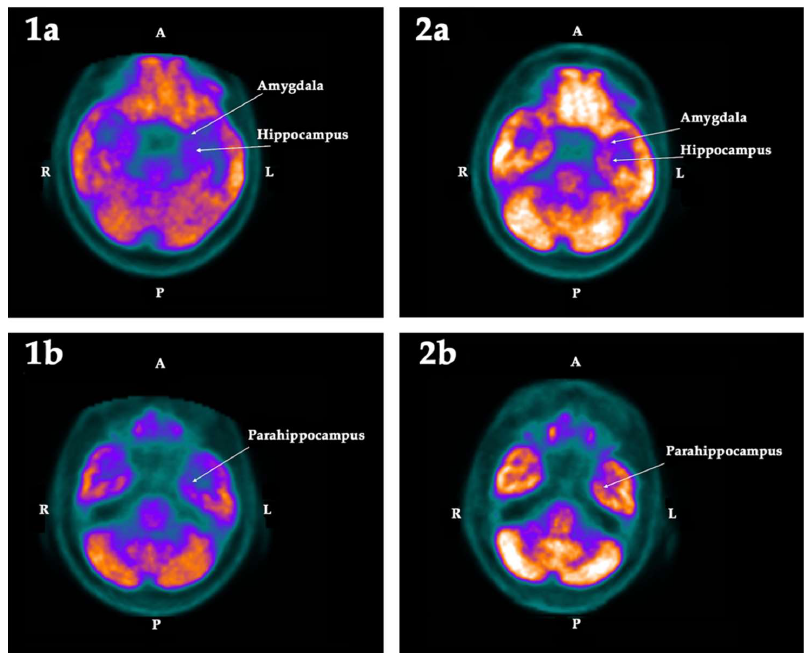
Figure 1. Cross section of the brain showing the metabolic activity in the left amygdala and left hippocampus ( 1a ) and the left parahippocampus ( 1b ), in the first (1) and the second (2) PET-SCAN studies. Note that the low metabolic activity in the structures observed in the first PET-SCAN was normalized in the left amygdala and the left hippocampus ( p < 0.025) after treatment with GH ( 2a ), but it was not statistically significant in the left parahippocampus ( 2b ). A: Anterior. R: Right. L: Left. P: Posterior.